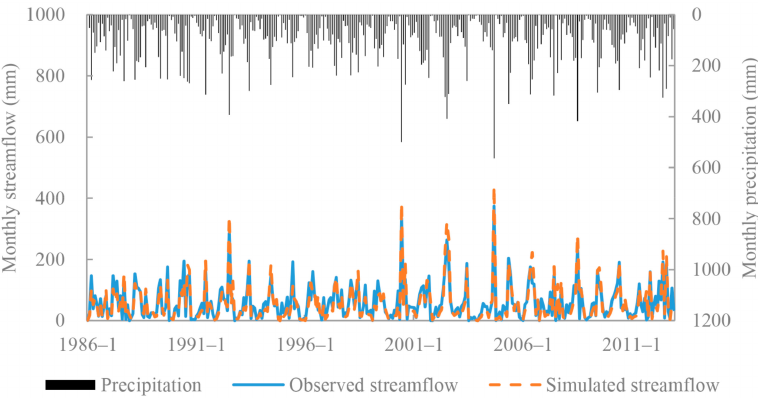
Figure 6. Comparison of monthly streamflows between measured and simulated values at 36-Foot